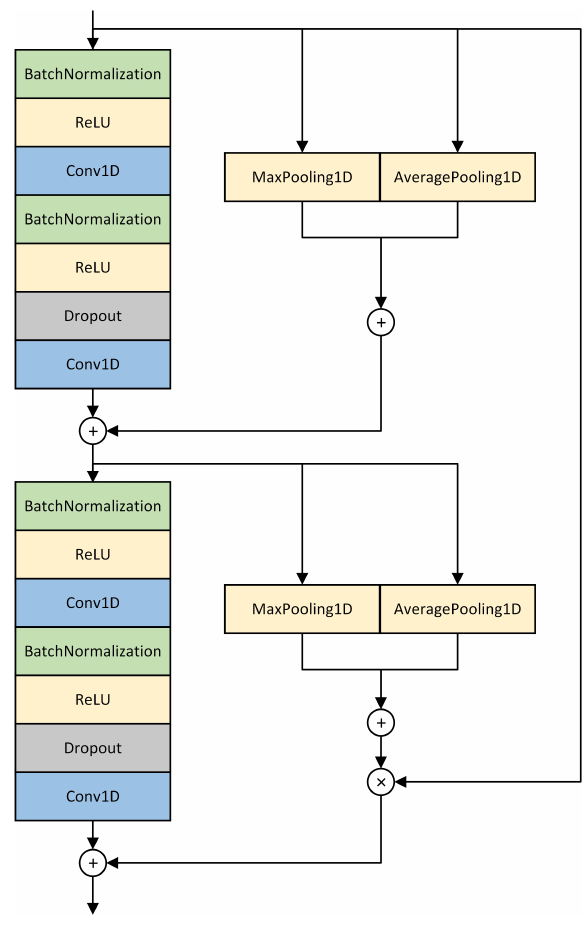
Figure 7. FRRNet residual module